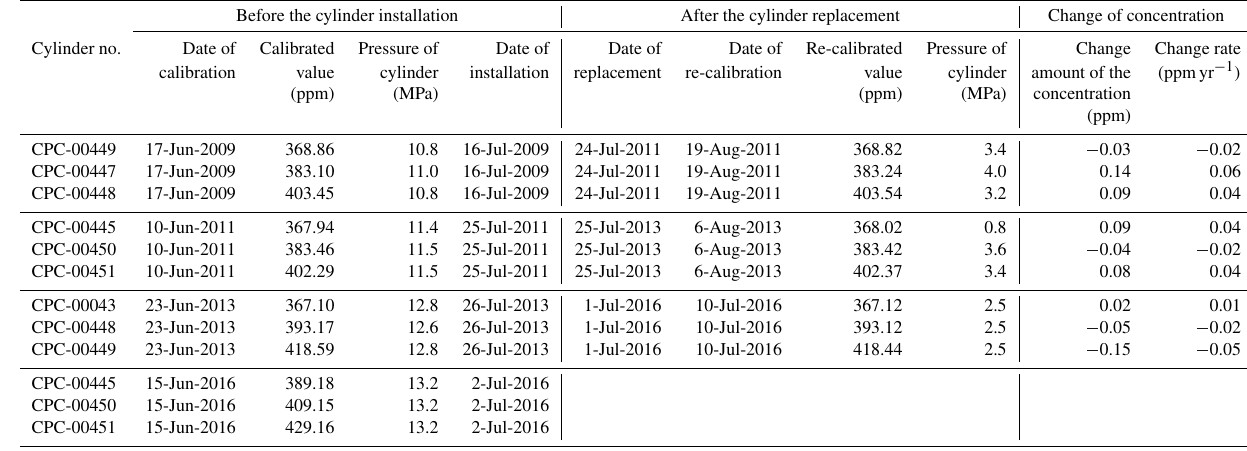
Table 1. Location of Mt. Fuji (35.21 ◦ N, 138.43 ◦ E) and of other sites representative for the long-term observation of atmospheric CO 2 concentration in Japan (small black dots), and the five areas used for back-trajectory analysis of air mass origins (Siberia, China, Southeast Asia, around Japan, and Pacific Ocean). Before the cylinder installation After the cylinder replacement Change of concentration Cylinder no.